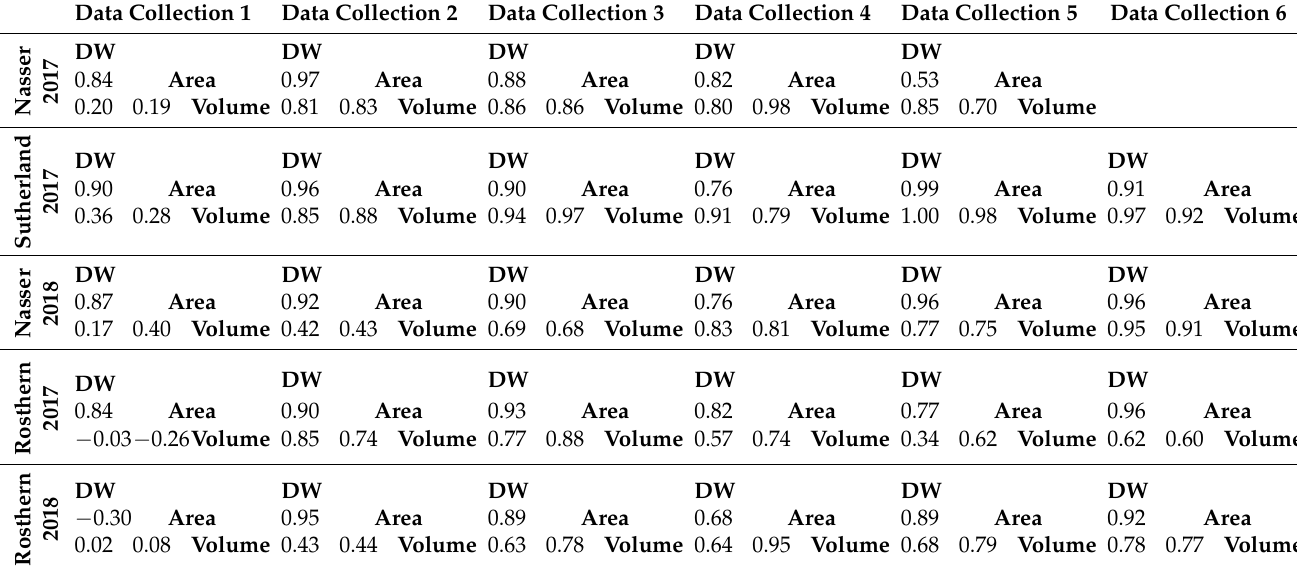
Table 1. Data collection at each location began two weeks after emergence and was repeated ap- proximately every two weeks until all genotypes reached physiological maturity. Correlations were determined between dry weight (DW), vegetation area (Area), and plot volume (Volume) at each data collection time and site